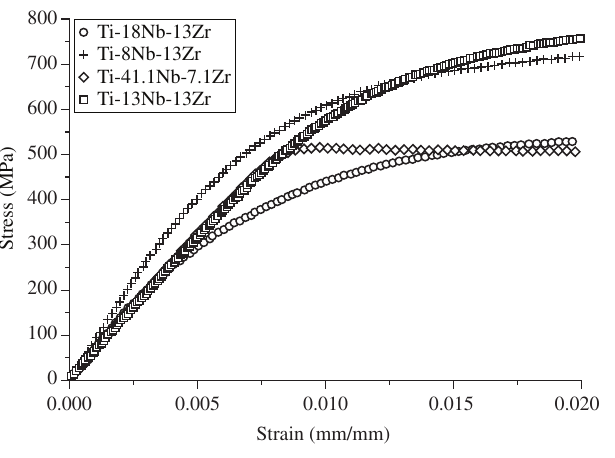
Figure 5. Secant modulus versus stress for Ti-Nb-Zr